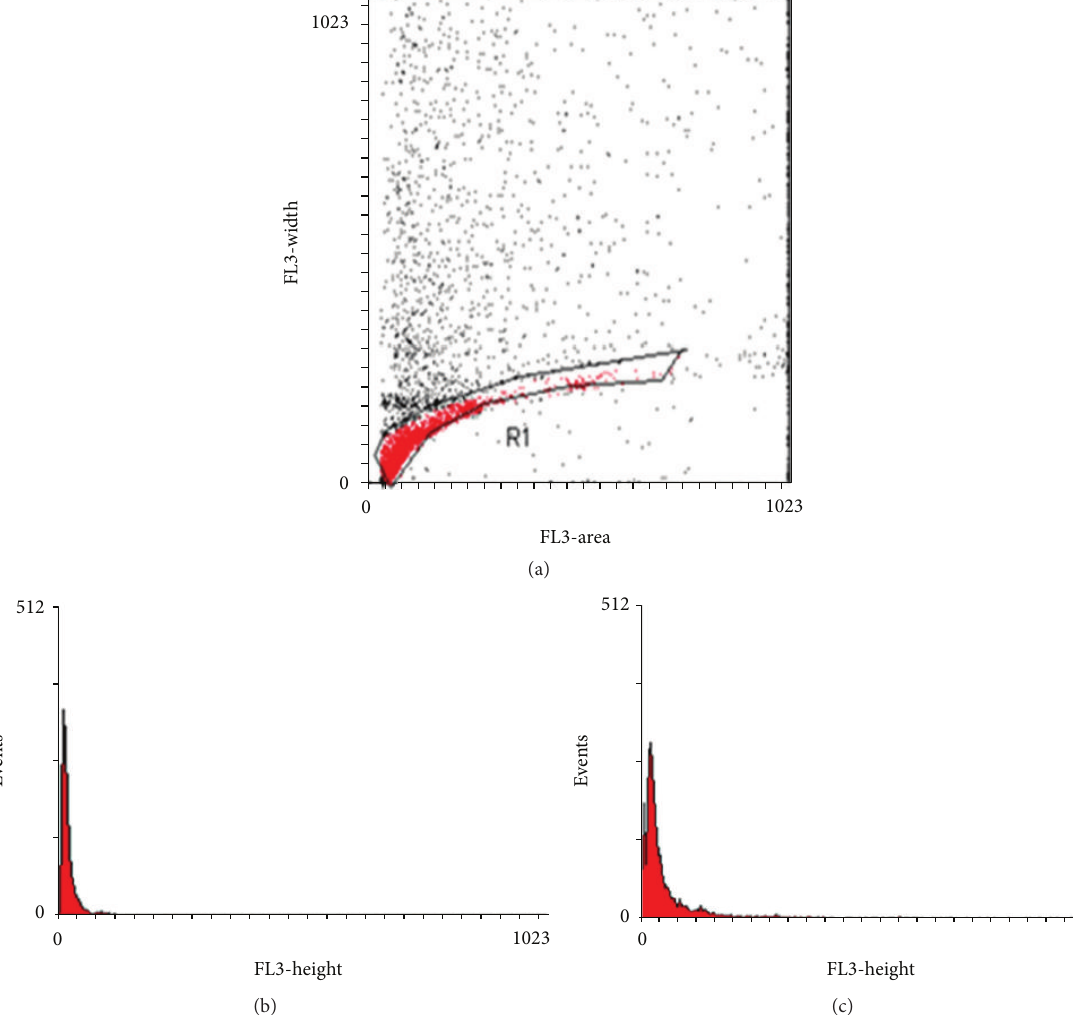
Figure 2: Flow cytometric detection of sperm DNA chromatin condensation. (a) Dot plot histogram (FL3A versus FL3W) obtained after propidium iodide staining of spermatozoa. Cells gated in R1 region were analyzed, while debris and aggregates were excluded from the analysis. The fluorescence intensity of cells (spermatozoa) was measured in R1 gate. (b) Histogram of fluorescence intensity of spermatozoa from normal control person. (c) Histogram of fluorescence intensity of spermatozoa from infertile person with